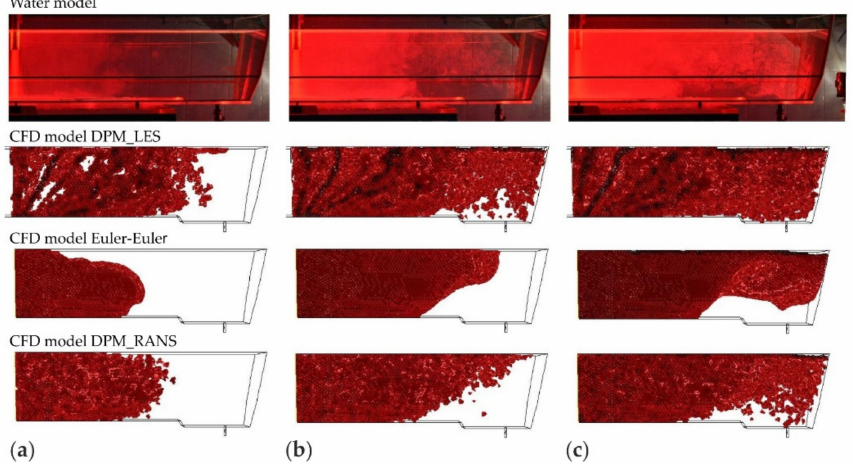
Figure 9. The location of the microparticles (fraction 50 µ m) in the tundish model for a duration of, respectively: ( a ) 25, ( b ) 60, ( c ) 120 s.